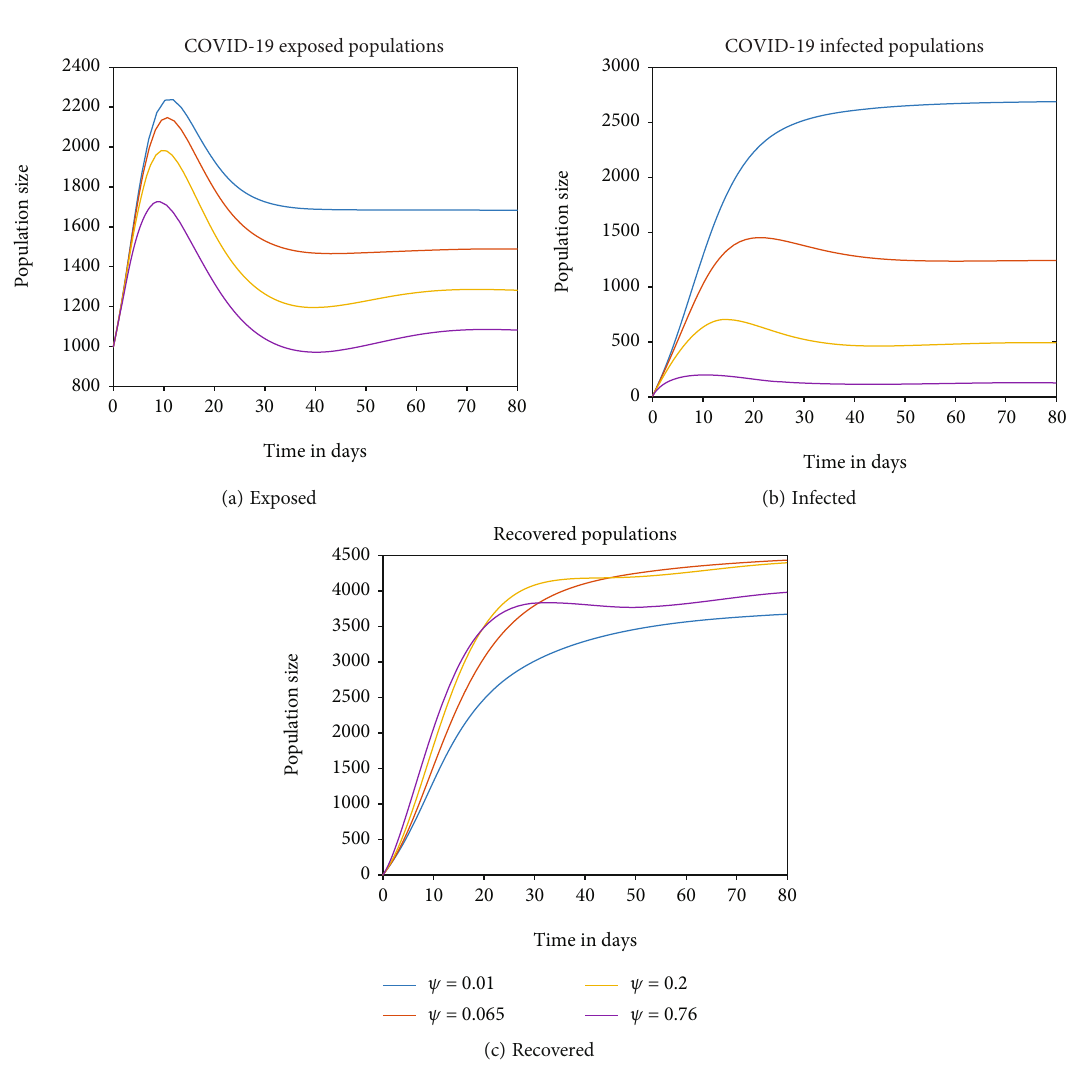
Figure 7: The e ff ect of the recovery rate of infected individuals ( ψ ) for the COVID-19 only